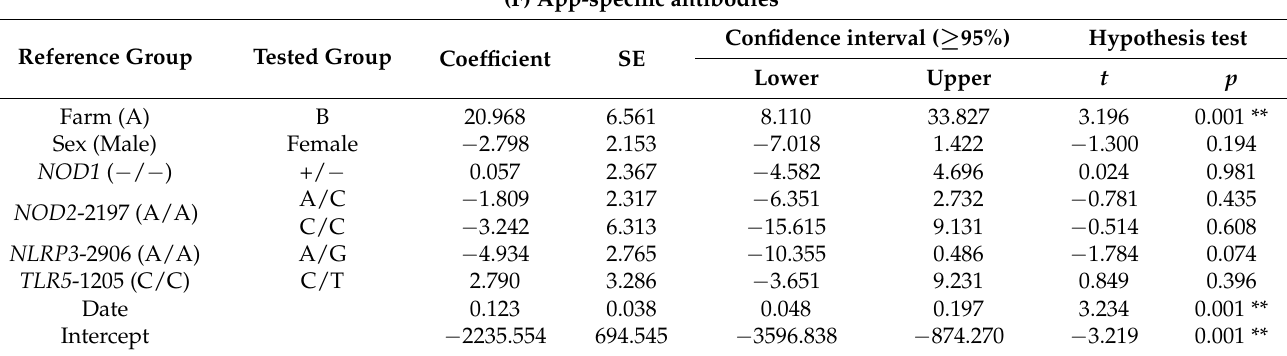
(F) App-specific antibodies